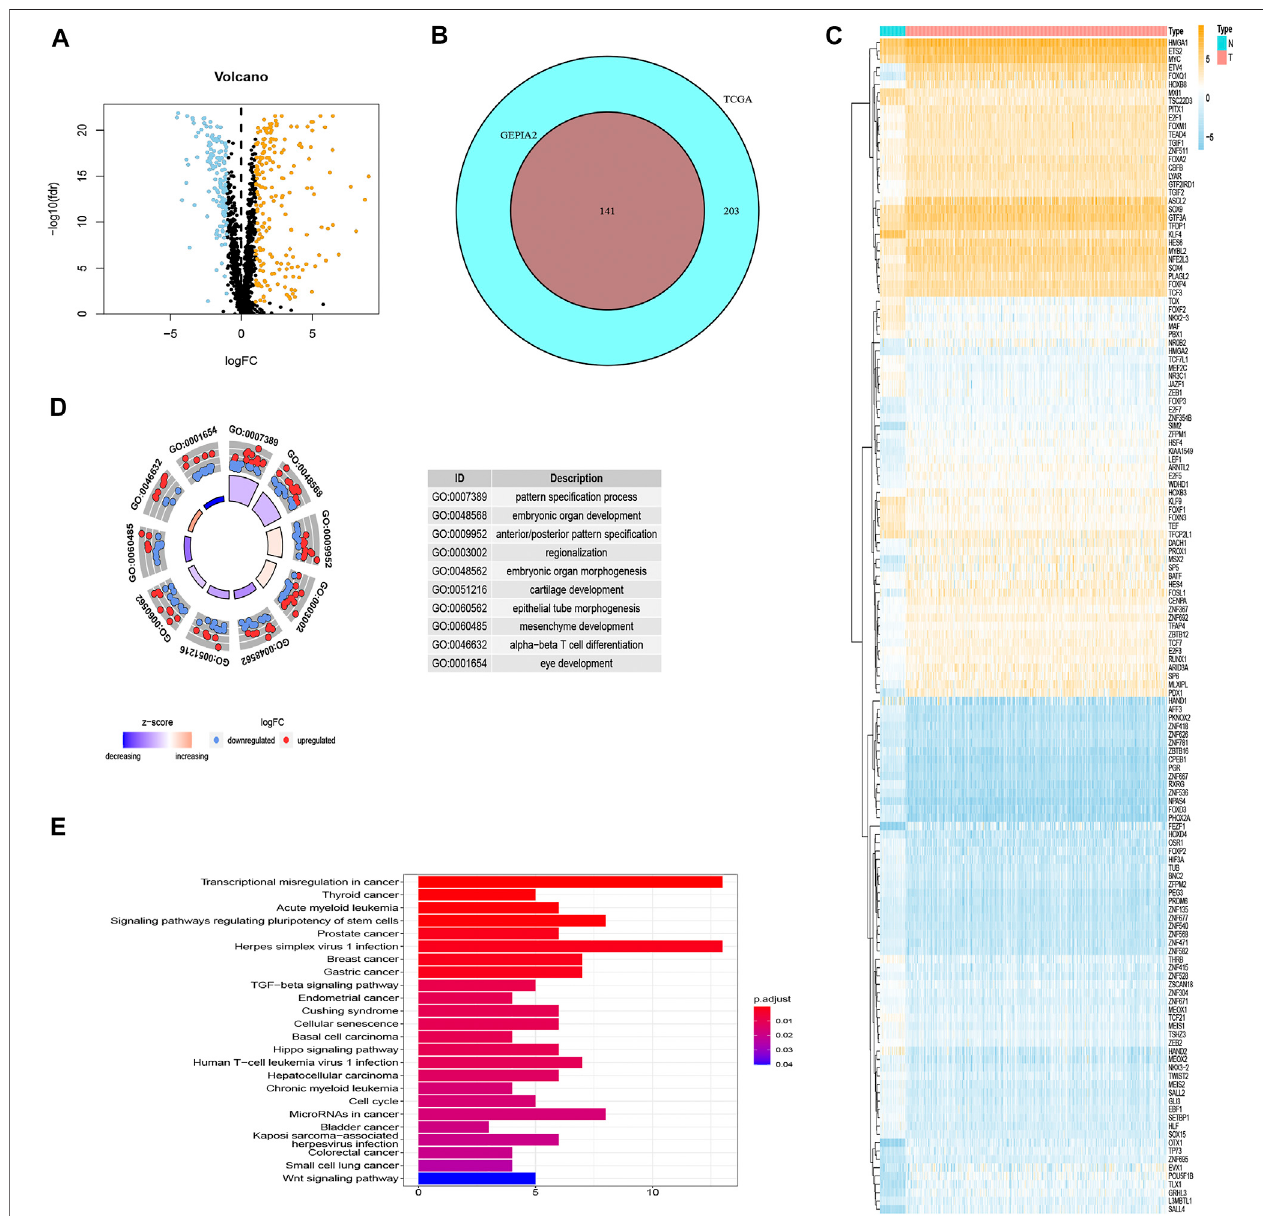
FIGURE 2 | The results of differential gene analysis. (A) The volcano plot of differentially expressed TF-related genes based on TCGA. The sky blue points are the downregulatedgenes,theorangepointsaretheupregulatedgenes,representing p < 0.05,|log 2 FC| > 1. (B) TheVennplottoshowthesamedifferentiallyexpressed TF- related genes between TCGA and GEPIA2 database. (C) The heatmap of differentially expressed TF-related genes. The vertical axis refers to genes, the horizontal axis referstodifferencesingeneexpressionbetweentissues,theorangemeanshighexpression,andtheskybluemeanslowexpression. (D) GeneOntology(GO)circle graph of the top 10 GO terms with the most enriched genes. (E) Bar graph of the top 24 Kyoto Encyclopedia of Genes and Genomes (KEGG) pathway with the most enriched genes; the vertical axis refers to names of pathways, and the horizontal axis refers to the number of genes.